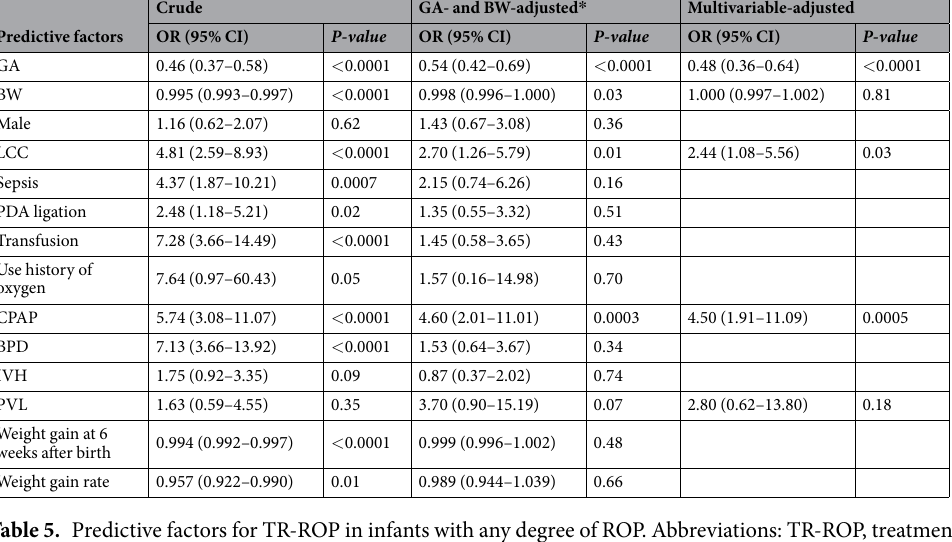
Table 5. Predictive factors for TR-ROP in infants with any degree of ROP. Abbreviations: TR-ROP, treatment- requiring retinopathy of prematurity; GA, gestational age; BW, birthweight; OR, odds ratio; CI, confidence interval; LCC, late-onset circulatory collapse; PDA, patent ductus arteriosus; CPAP, continuous positive airway pressure; PMA, postmenstrual age; BPD, bronchopulmonary dysplasia; CNS, central nervous systems; IVH, intraventricular hemorrhage; PVL, periventricular leukomalacia. * GA is BW-adjusted and BW is GA-adjusted.